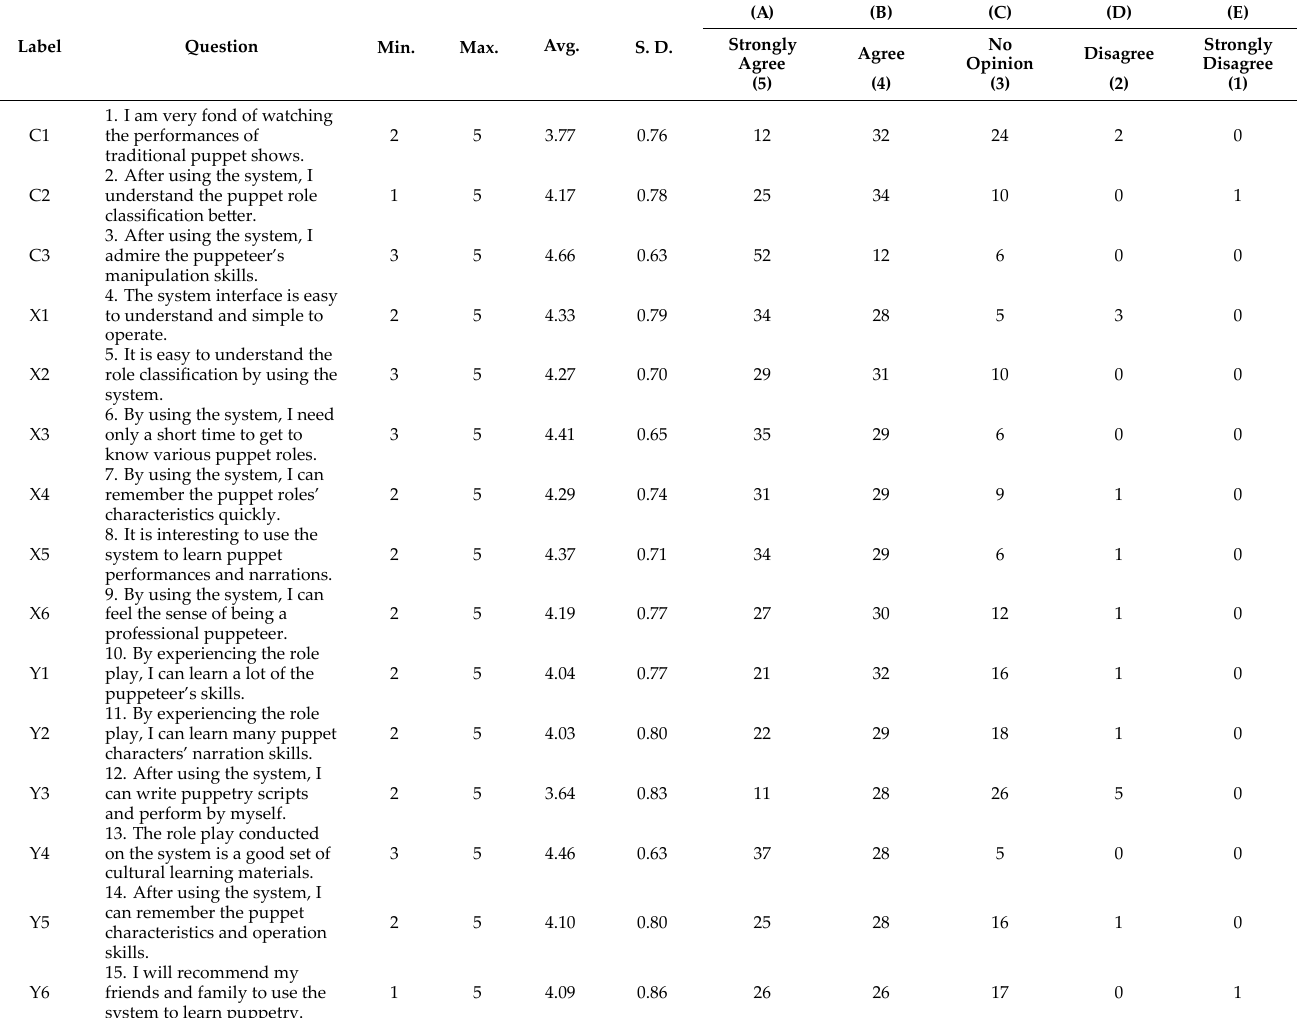
Table 7. The questions asked in the questionnaire survey and the statistical data of the Likert‑scale scores of the answers to